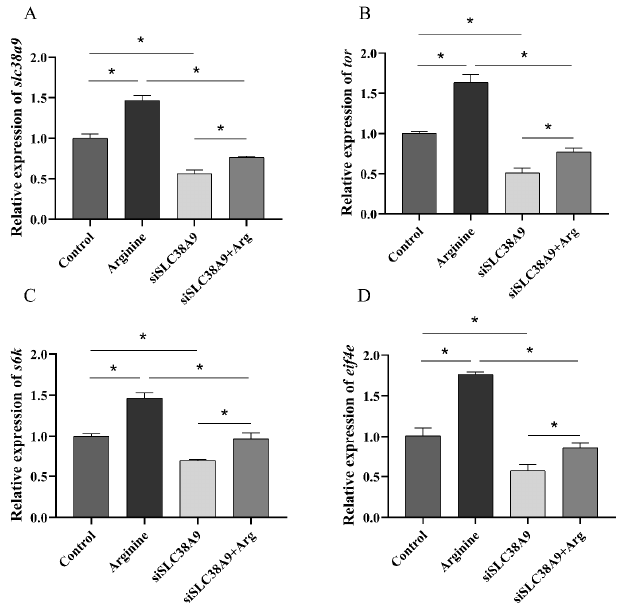
Figure 5. Effect of slc38a9 knockdown on arginine-induced activation of the TOR signaling pathway in muscle. Abalones were orally administered arginine (0.1 mmol/L, 100 µ L) or PBS after slc38a9 knockdown. The figures show the expression levels of ( A ) slc38a9 , ( B ) tor , ( C ) s6k and ( D ) eif4e in muscles after oral administration. Results are represented as mean ± SEM ( n = 3 replicate experiments), and asterisk (*) indicate a significant difference between the two groups ( p < 0.05). 3.2.4. Expressions of TOR Pathway Related Genes after Feeding and siRNA Injection Compared with the basal diet, the arginine-added diet increased the transcript levels of slc38a9 , tor , s6k and eif4e in abalone ( p < 0.05). The expression of slc38a9 had a peak after 6 h of feeding, and the expression levels of other genes reached the peak at 9 h (Figure 6). Furthermore, feeding after siRNA- slc38a9 injection also up-regulated the expression levels of slc38a9 , tor , s6k and eif4e ( p < 0.05); however, the expression levels of these genes were significantly lower than that in abalone without siRNA injection ( p < 0.05).